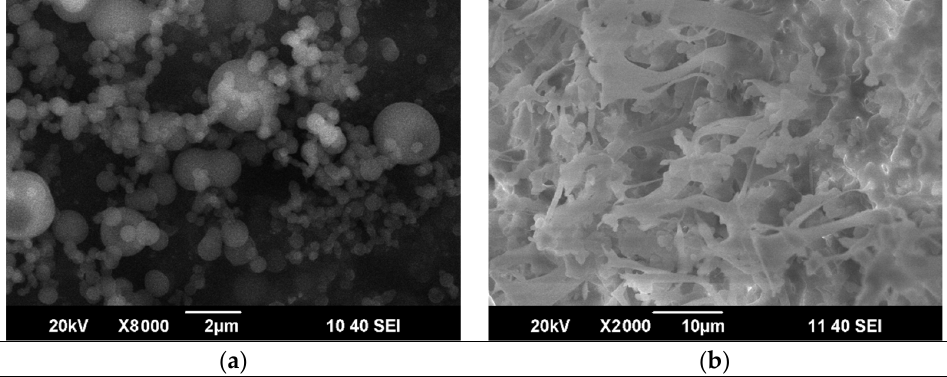
Figure 4. Scanning electron microscopy (SEM) images of the PC particles micronized at the 1 mL/min ( a ) and 2 mL/min ( b ) solution flow rates. 150 bar, 25 g/L.